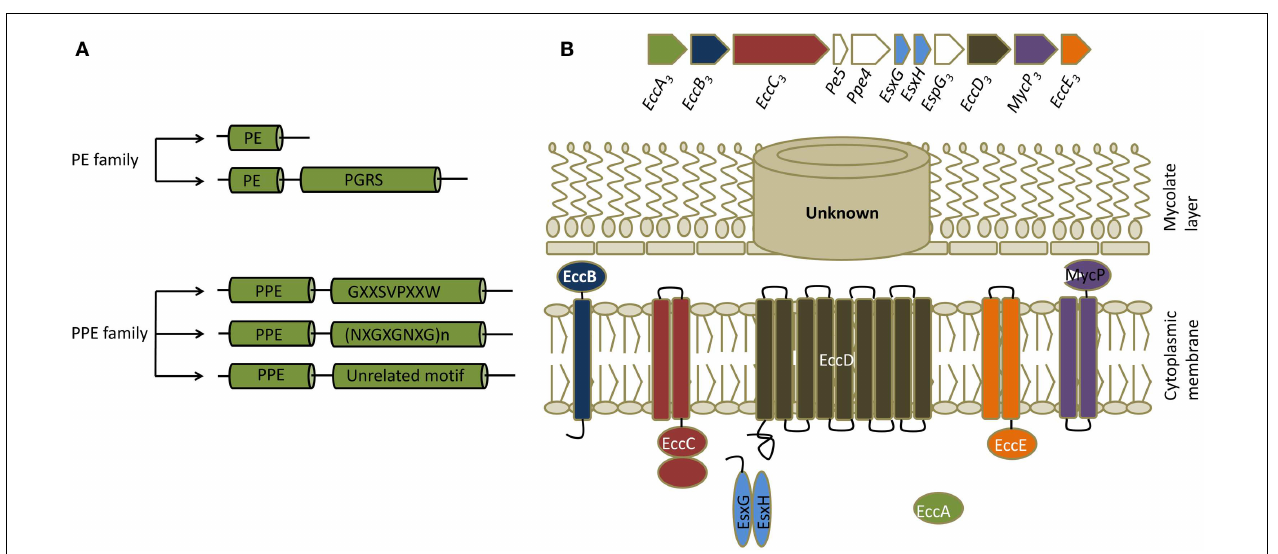
(designated ESX-1 through ESX-5 systems) or partial clusters. In addition to the two Esx genes, complete ESX clusters encode four core